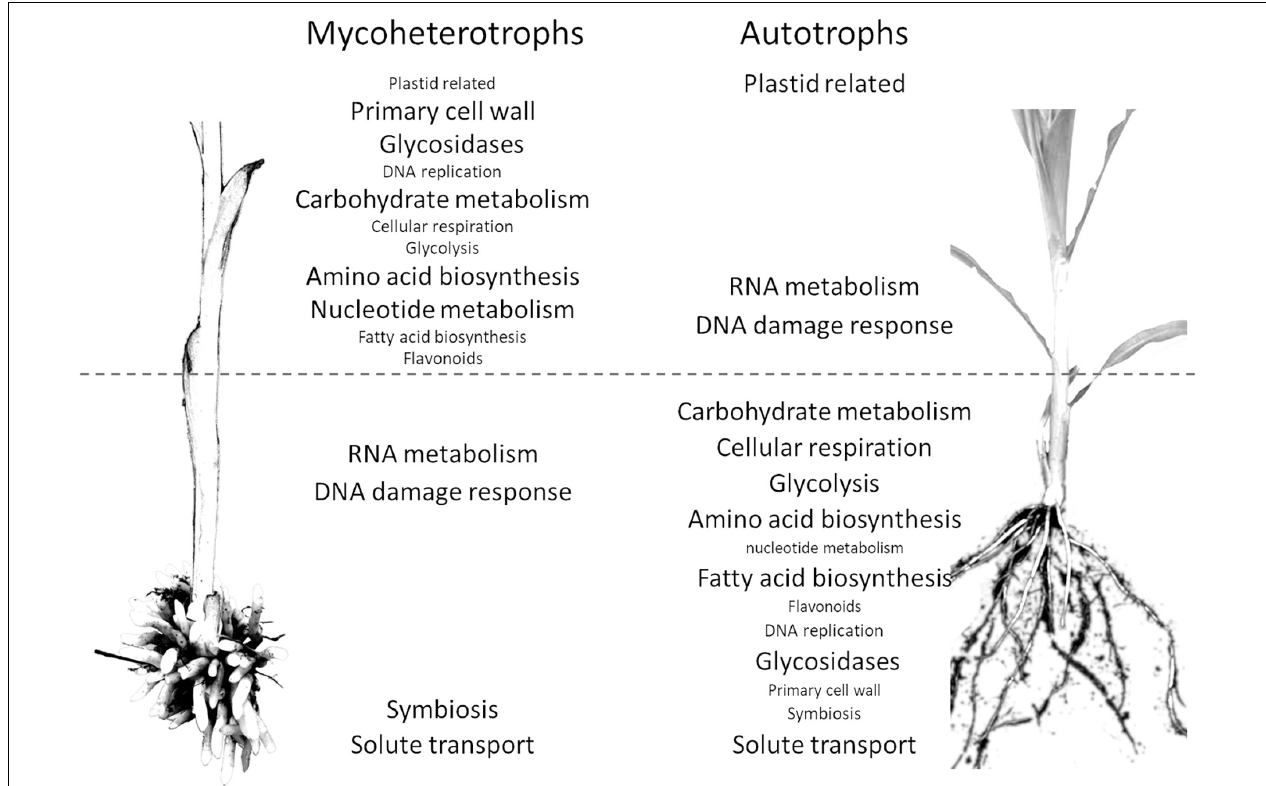
FIGURE 4 | Comparison of distribution of pathways between the organs of mycoheterotrophic orchids and autotrophic non-orchid plants. Pathways enriched in the orthogroups showing a significantly different underground organ/stem expression ratio between mycoheterotrophic species ( N. nidus-avis and E. aphyllum ) and autotrophic species ( B. distachyon and Z. mays ). The pathways are indicated in the organ where their expression is highest. The pathways shown with a large font are also differentially expressed between underground organ and